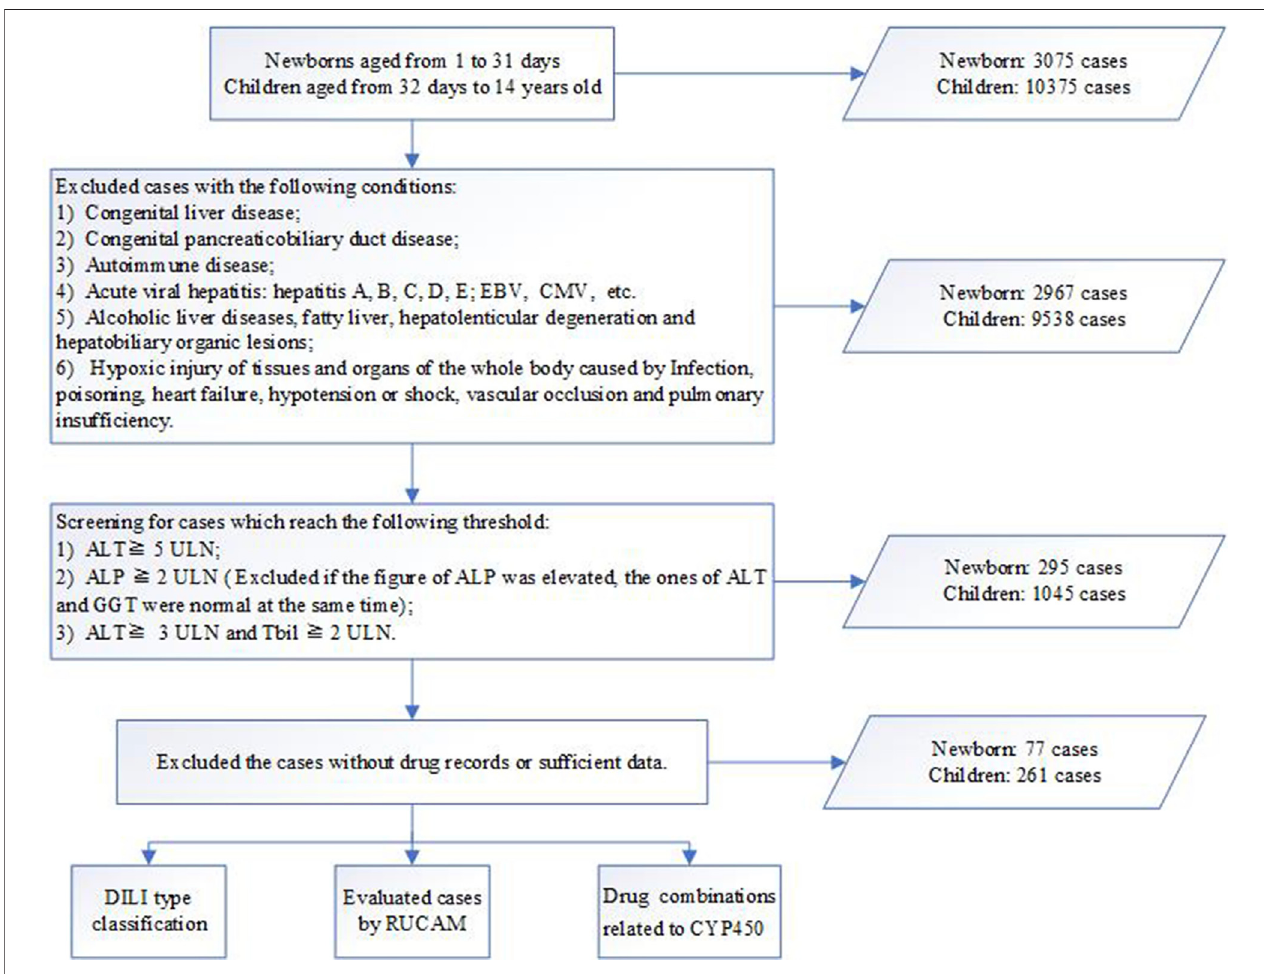
FIGURE1| Work fl owfordiagnosis,classi fi cationandevaluationofdrug-inducedliverinjury(DILI).ALT,alaninetransaminase;ALP,alkalinephosphatase;Tbil,total bilirubin; ULN, upper limit of normal; RUCAM, updated Roussel Uclaf Causality Assessment Method; DDIs, drug-drug induced interactions.